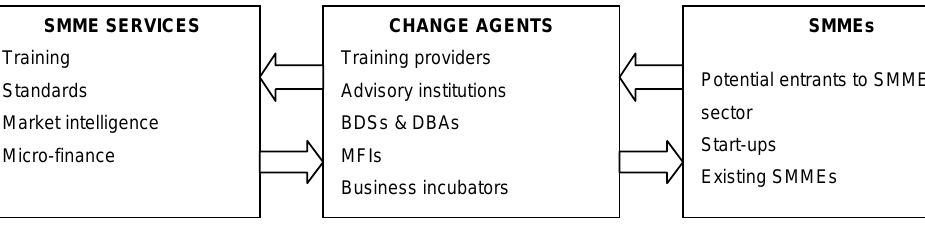
Source: Adapted from Ronan